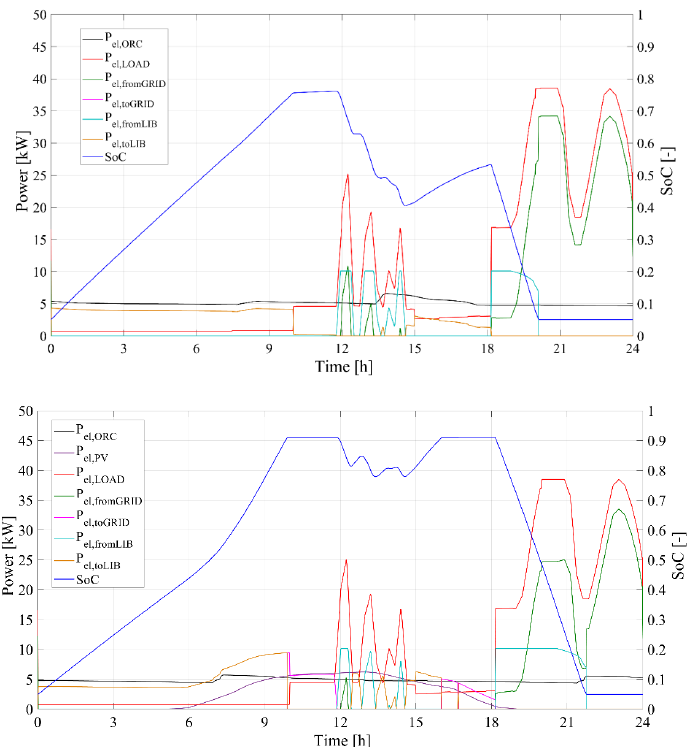
Figure 4. Dynamic results, typical summer working day: Case ETC ( above ) and Case PV ( below ).